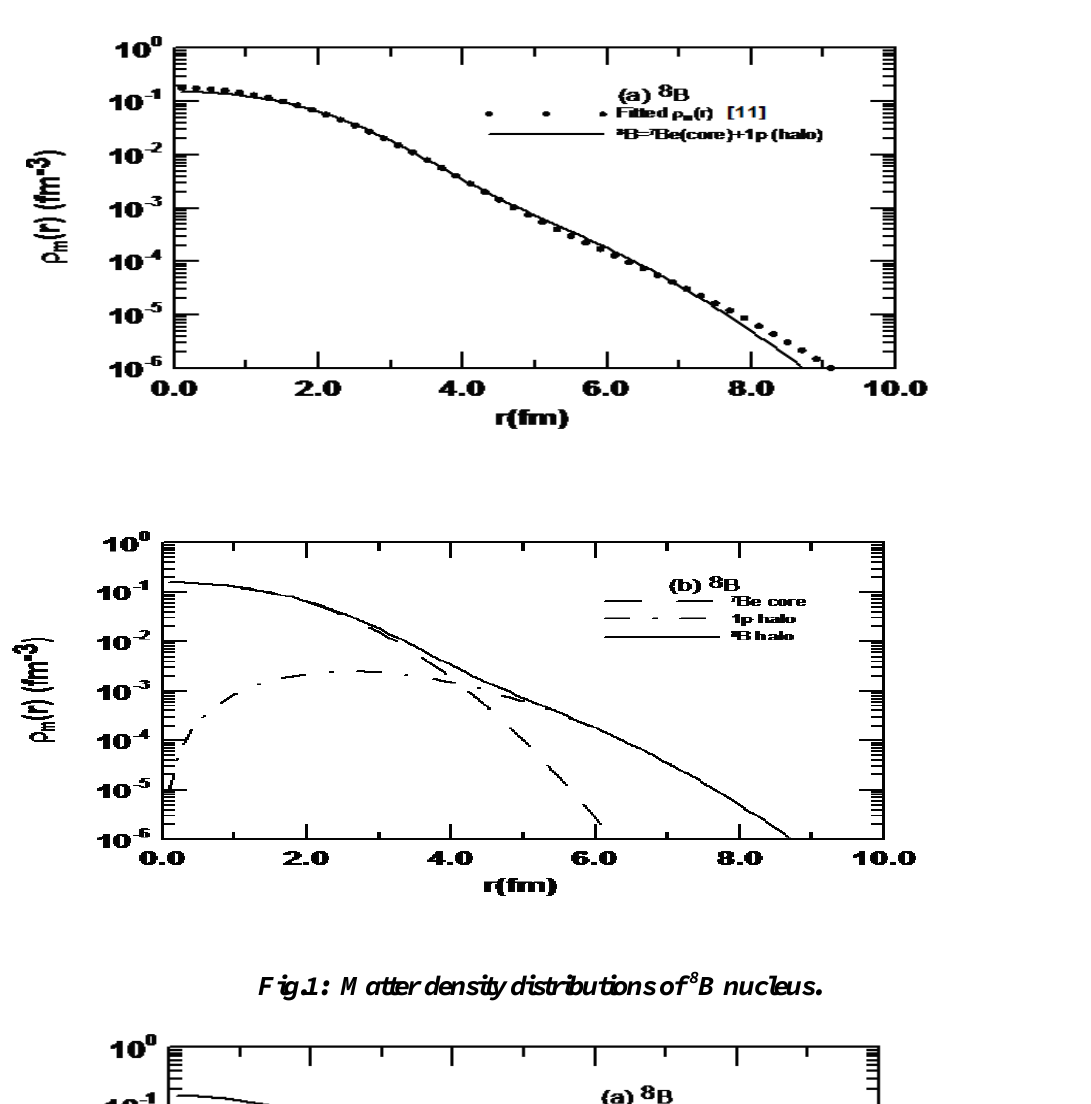
Fig.1: Matter density distributions of 8 B nucleus.